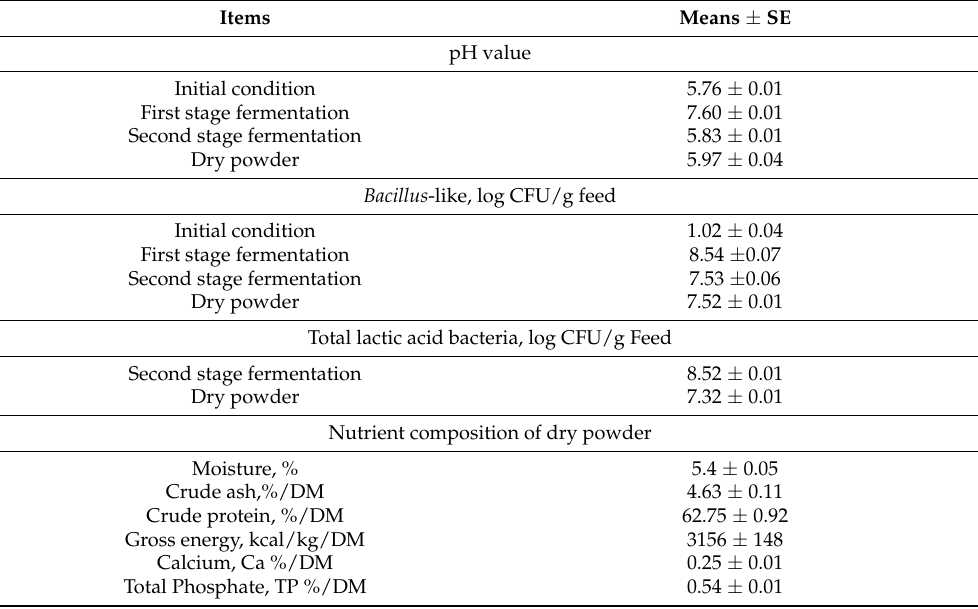
Table 3. Physical and chemical analysis of